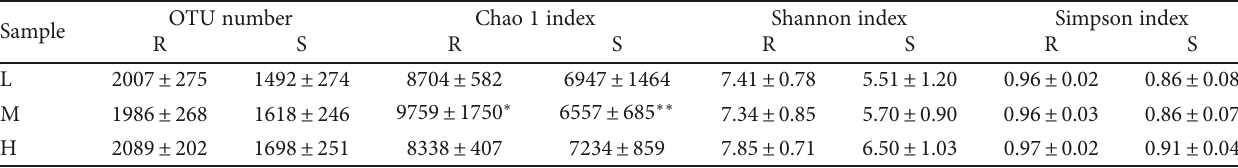
Table 2: Diversity estimation of the 16S rRNA gene libraries for the R- and S-samples.